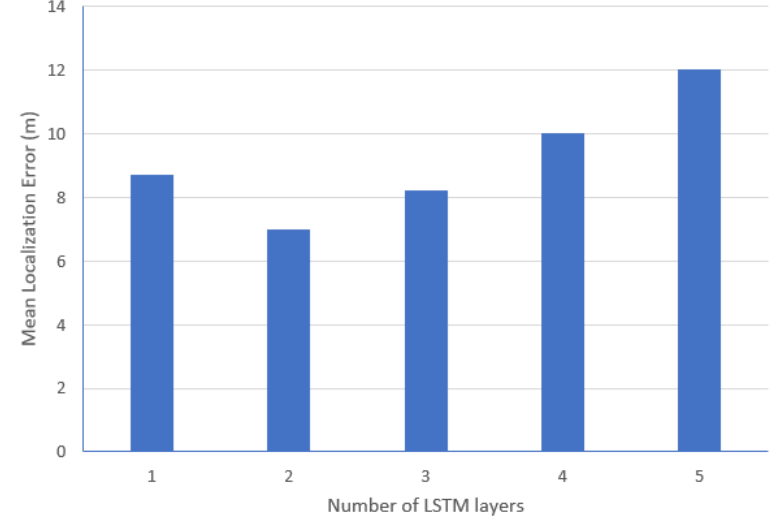
Figure 16. Mean localization errors with different number of LSTM layers.